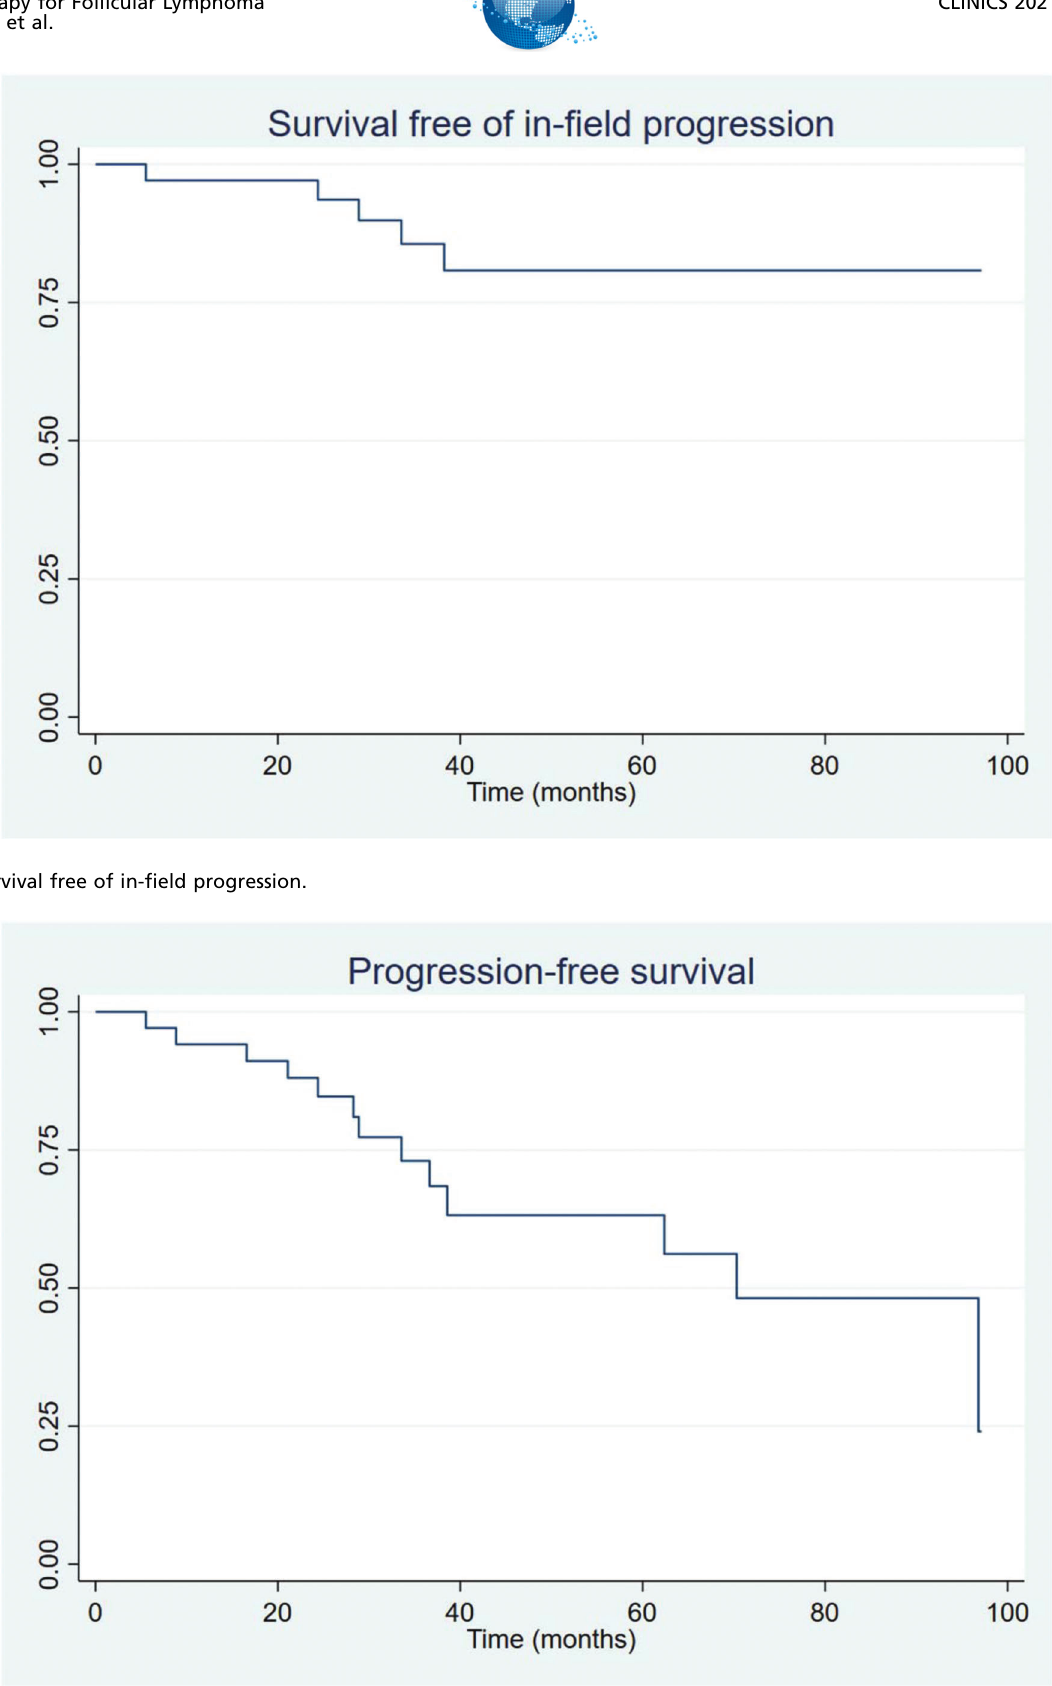
Fig 4 - Progression-free survival.